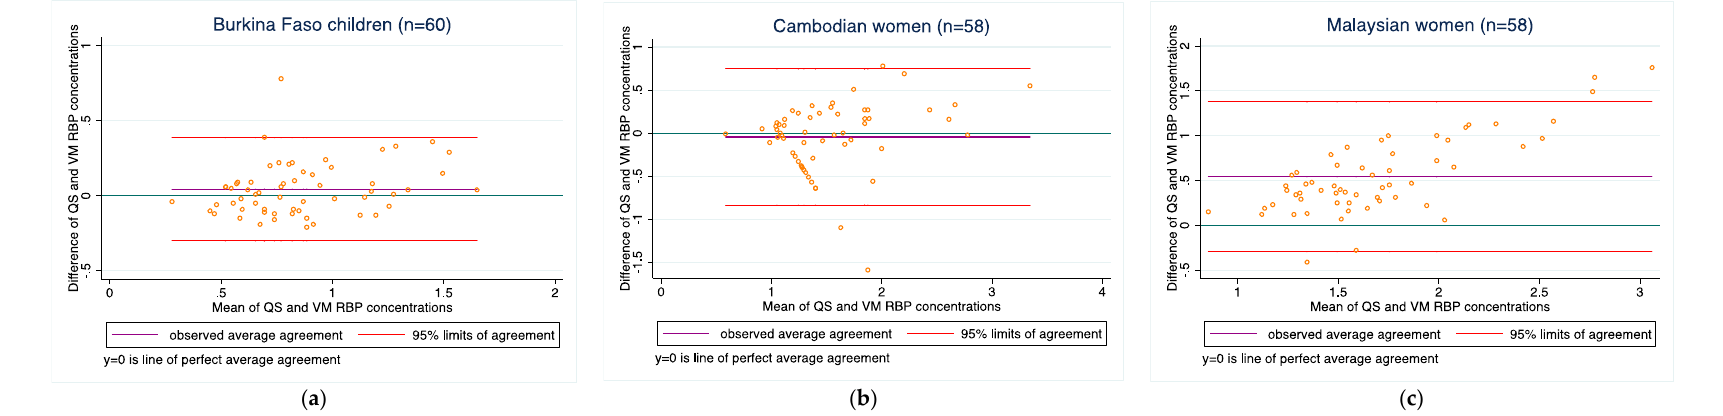
Figure 5. RBP concentrations for ( a ) Burkina Faso children ( n = 60); ( b ) Cambodian women ( n = 58); and ( c ) Malaysian women ( n = 58).